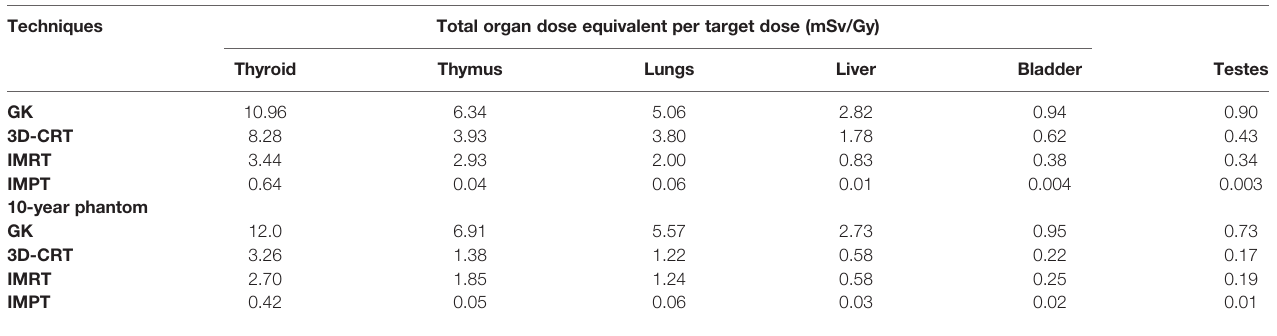
TABLE 3 | Comparison of measured total organ dose equivalent in selected organs for different techniques for the same brain tumor treatment in 5- and 10-year-old phantom.